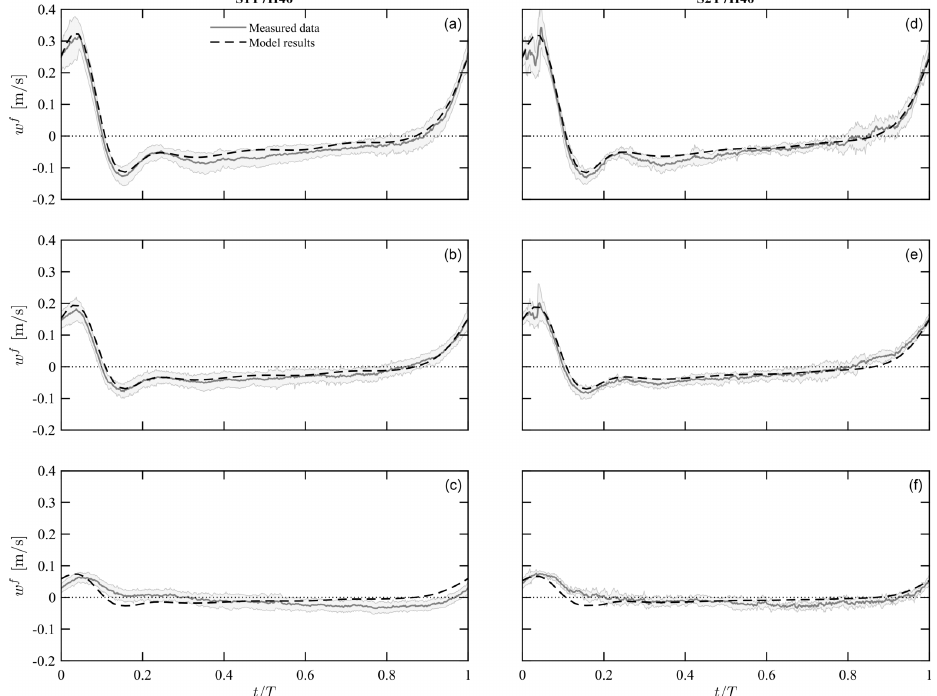
Figure 5. Time series of vertical fluid velocity, w f ( x , z , t / T ) , for measured data (gray solid curves, phase-averaged; gray envelopes, ± 1 standard deviation) and model results (black dashed curves) at x = 0. The vertical elevations were ( a ) z = 0.516 m, ( b ) z = 0.315 m, and ( c ) z = 0.121 m for S1T7H40 and ( d ) z = 0.511 m, ( e ) z = 0.310 m, and ( f ) z = 0.116 m for S2T7H40,